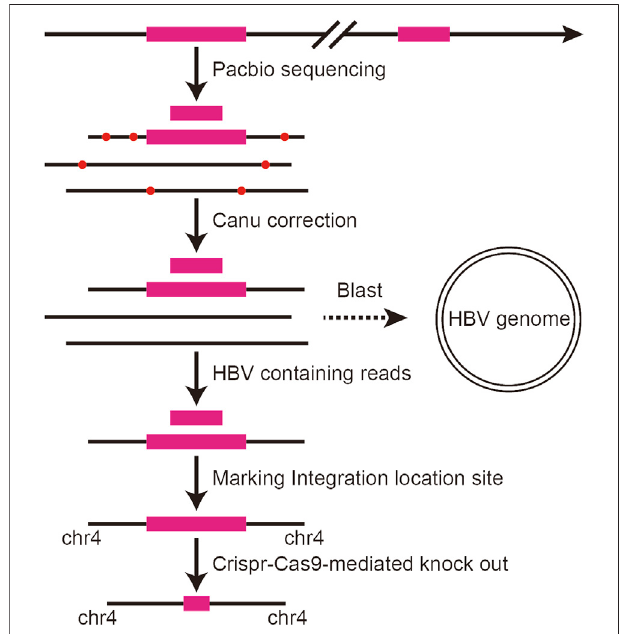
FIGURE 1 | Analysis fl ow chart of HBV integration in PLC/PRF/5